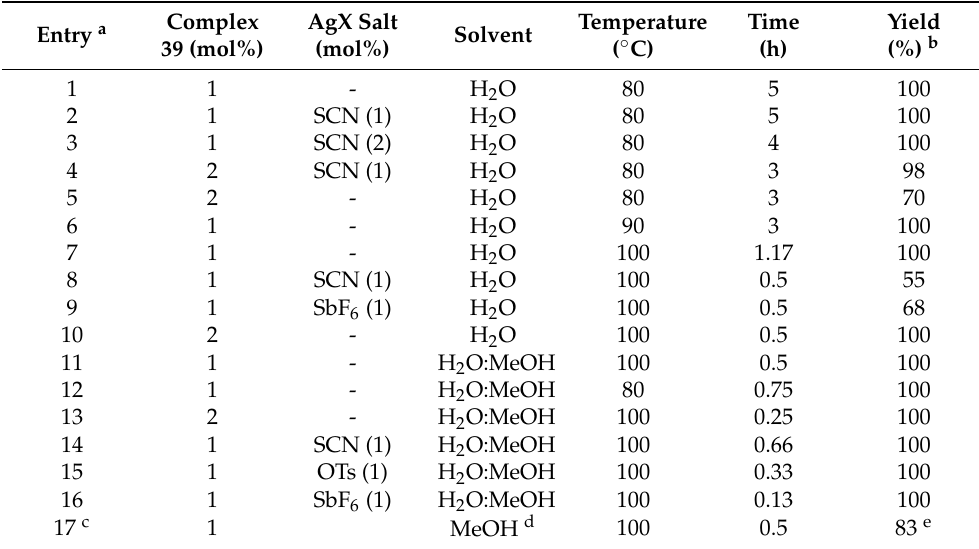
Table 14. Hydration of phenylacetylene promoted by complex 39 .